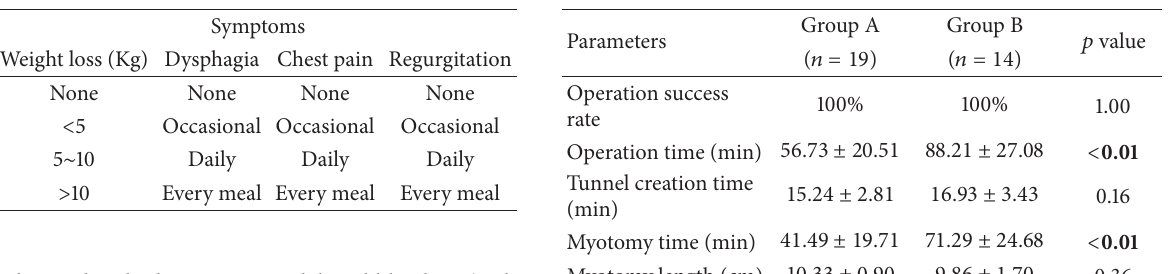
Table 2: Eckardt symptom score. Table 3: Procedure-related